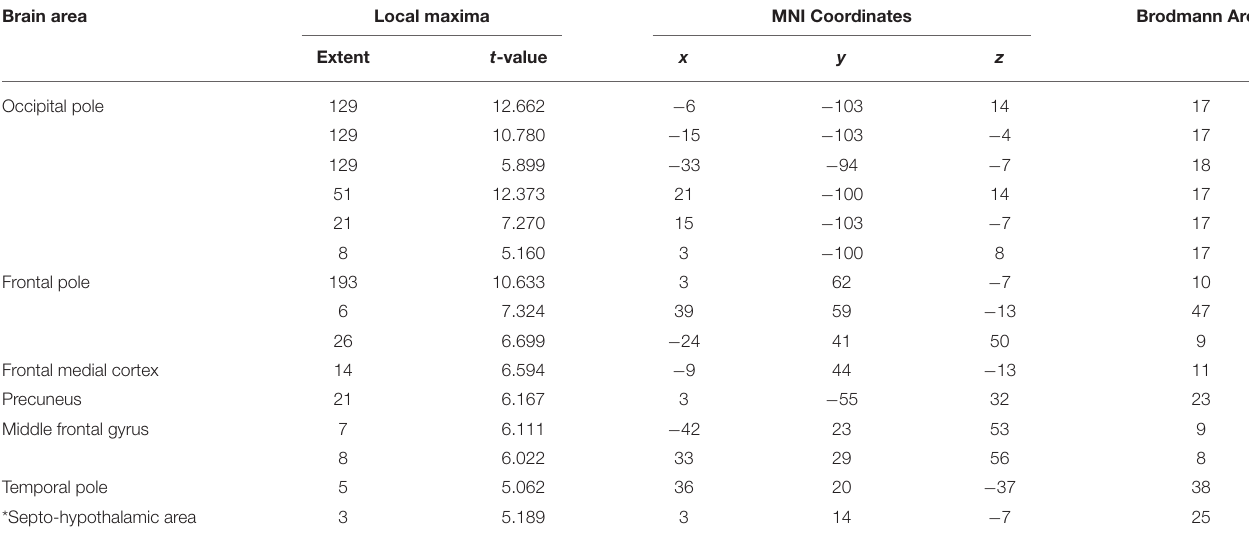
TABLE 2 | Overview of local maxima for brain activity during Tenderness versus Anguish neurofeedback conditions, across the whole brain. Brain area Local maxima MNI Coordinates Extent Occipital pole